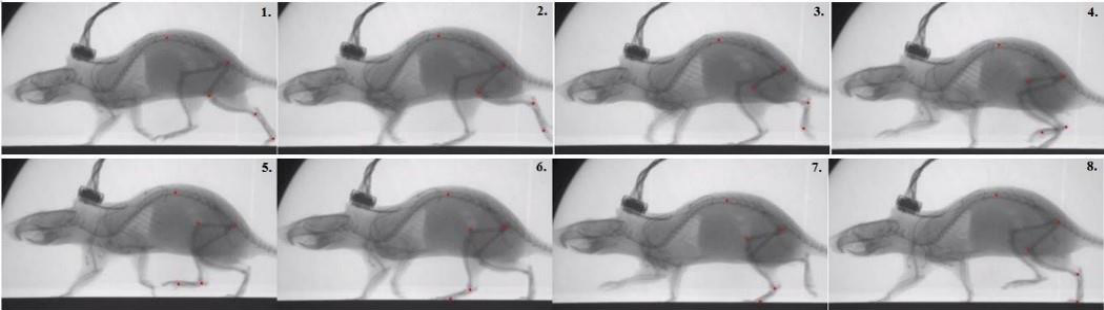
Figure 11. Images from X-ray video recordings of rat walking on a treadmill. Red marks are applied on the mid spine and all joints of a rat left hindlimb in order to track joint motion.